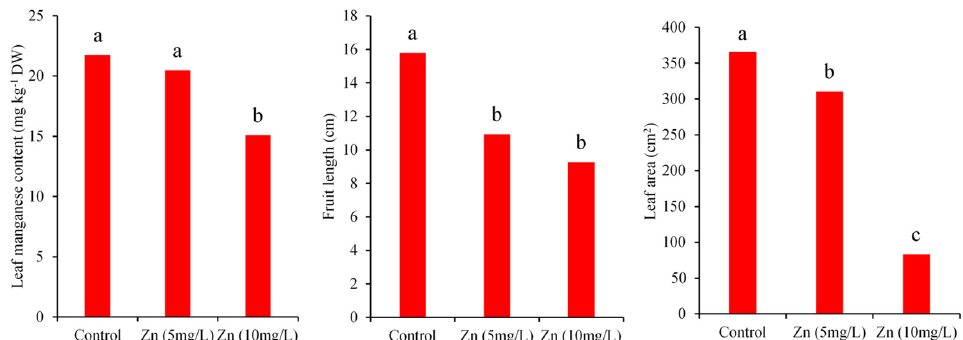
Figure 1. Main effects of added Zn concentration on leaf Mn content, fruit length, and leaf area of C. pepo L. The plot represents means of triplicates. Different alphabetic letters on each bar show significant differences at the 5% level between simple effects of treatments according to Duncan’s multiple range mean comparison test.